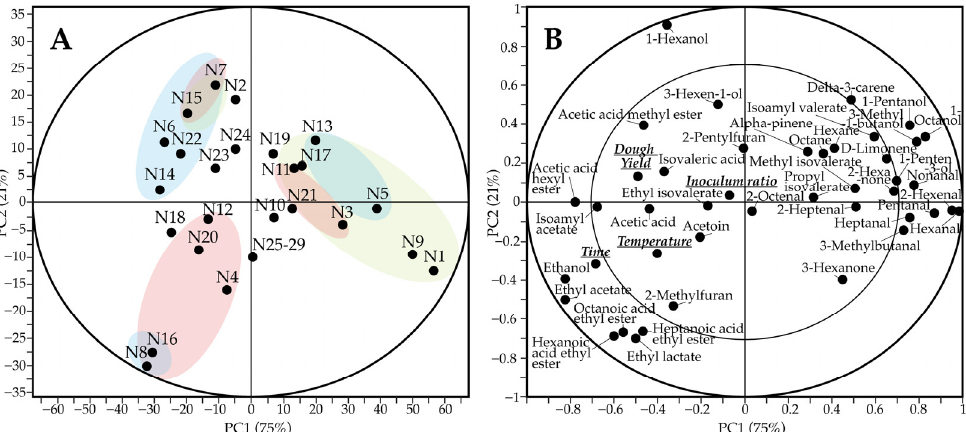
Figure 1. Scores ( A ) and correlation loading plots ( B ) of volatile compounds in fermented faba bean protein concentrate. Green circles—samples fermented for 10 h; red circles—samples fermented at 30 °C; blue circles, samples with dough yield of 400.